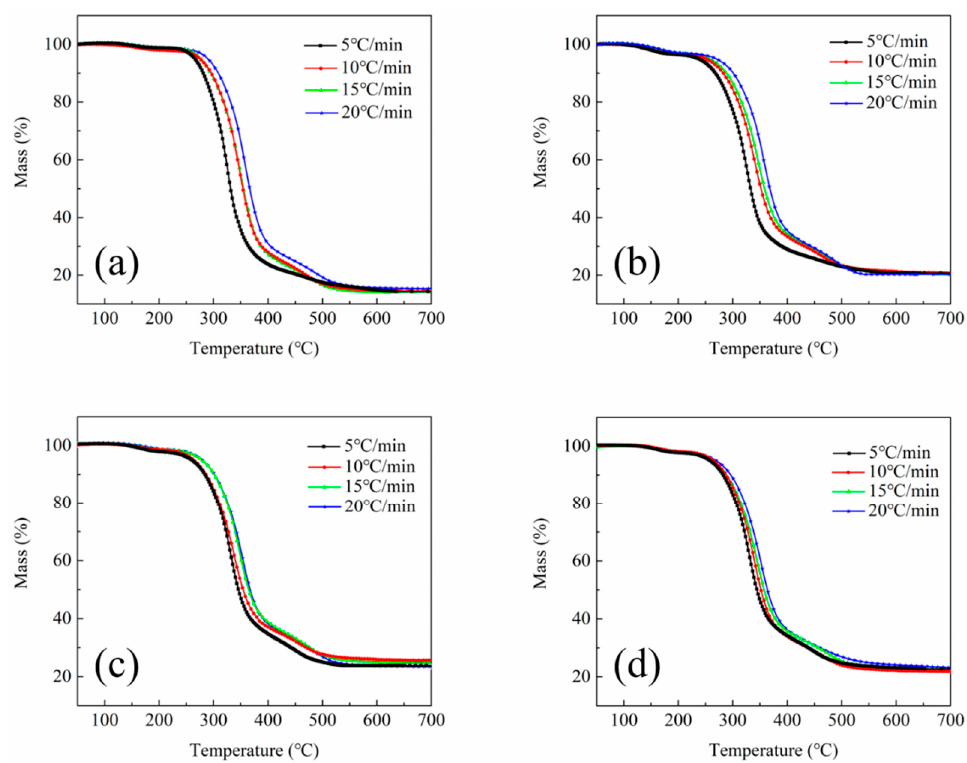
Figure 2. TG curves of the RPUF specimens in a nitrogen atmosphere at the heating rates of 5, 10, 15, and 20 °C·min − 1 : ( a ) RPUF; ( b ) FRPU; ( c ) FRPU/GO; and ( d ) FRPU/fGO.